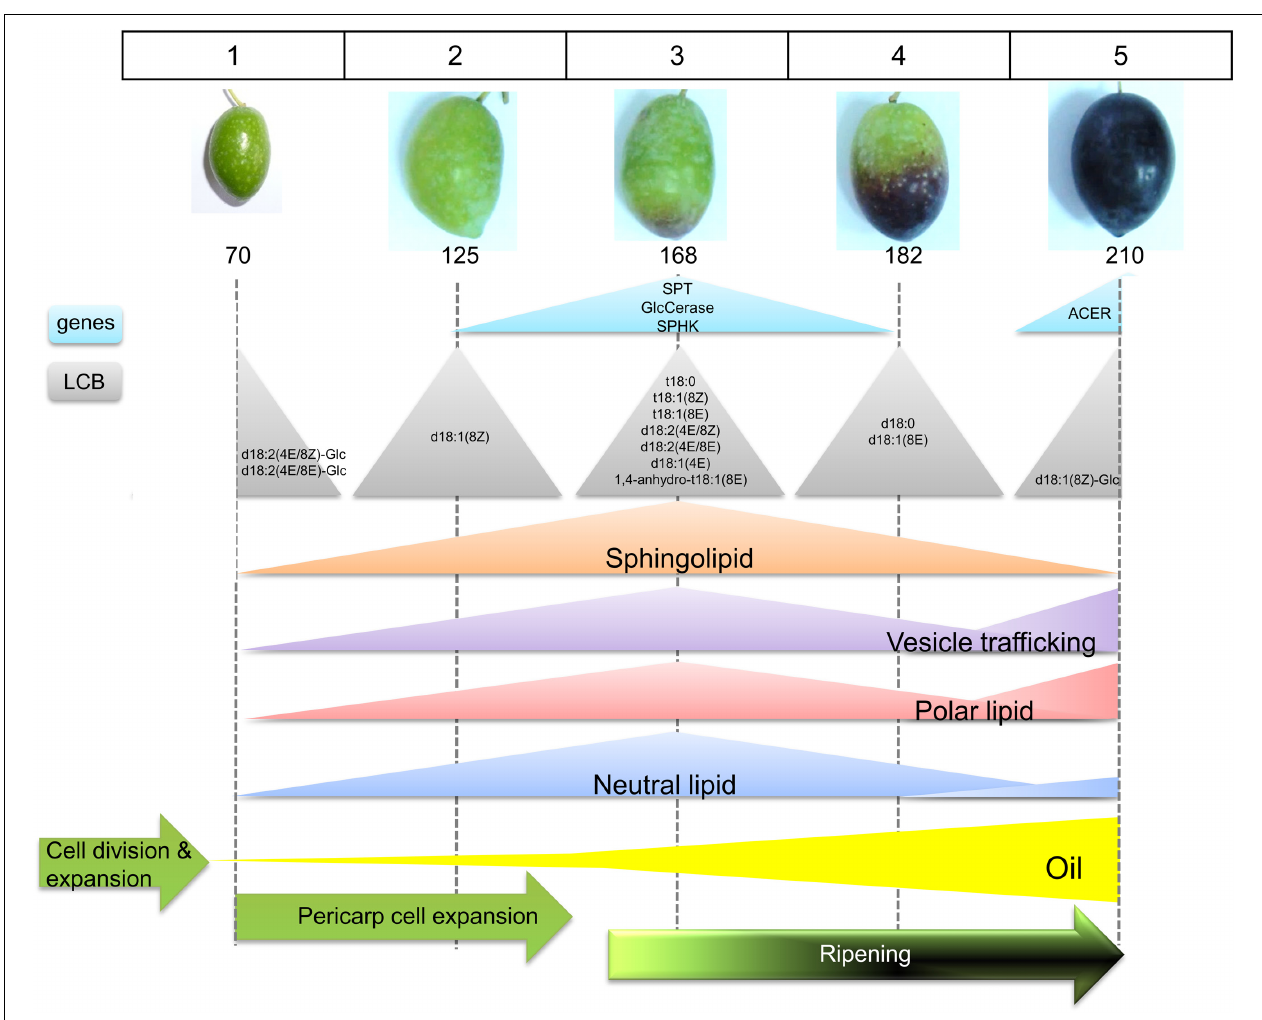
FIGURE 8 | Scheme representing the sphingolipid profiling during the phases of olive fruit development. See text for